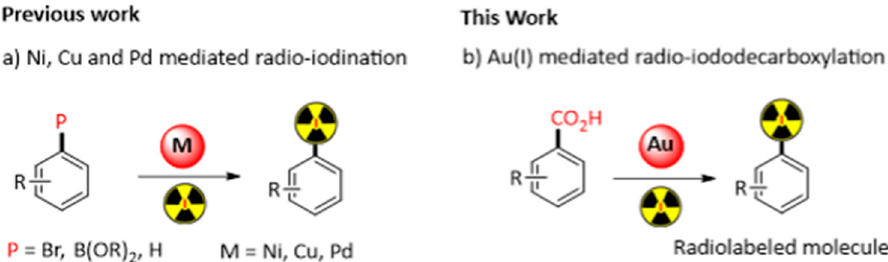
Figure 9. Transition metal mediated radio-iodination of arene.